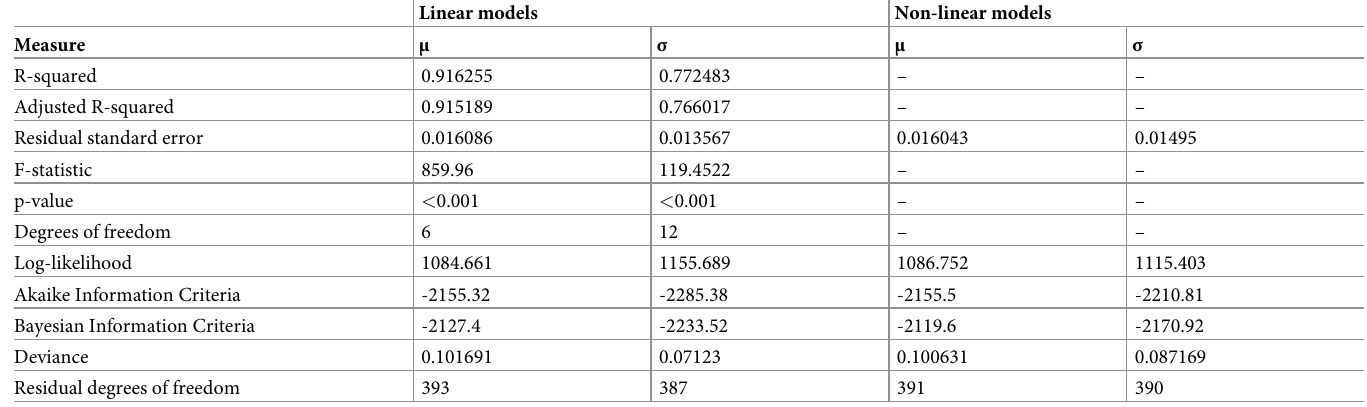
Table 2. Goodness of fit measures for the optimal